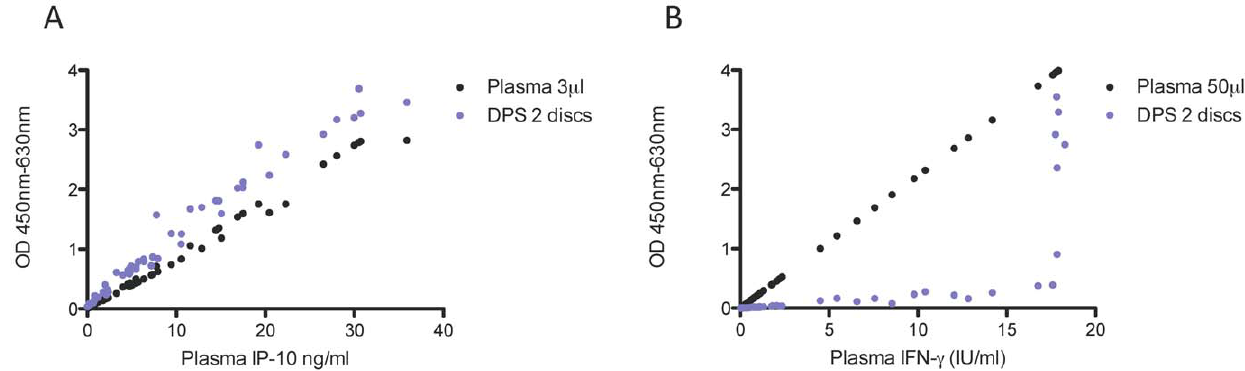
Figure 2. Magnitude of IP-10 (A) and IFN- c (B) responses to antigen and mitogen challenge determined in plasma and DPS samples. Optical density reading from 18 Quantiferon-TB positive donors were compared. Nil, antigen and mitogen samples were pooled, rendering a total of 54 data-points per graph. OD readings from plasma and DPS samples were plotted against the IP-10 or IFN-g concentration determined in the plasma sample corrected for the dilution factor. The optimal working range of the assay is OD 0–3, a steadily increasing regression line ensures high precision.